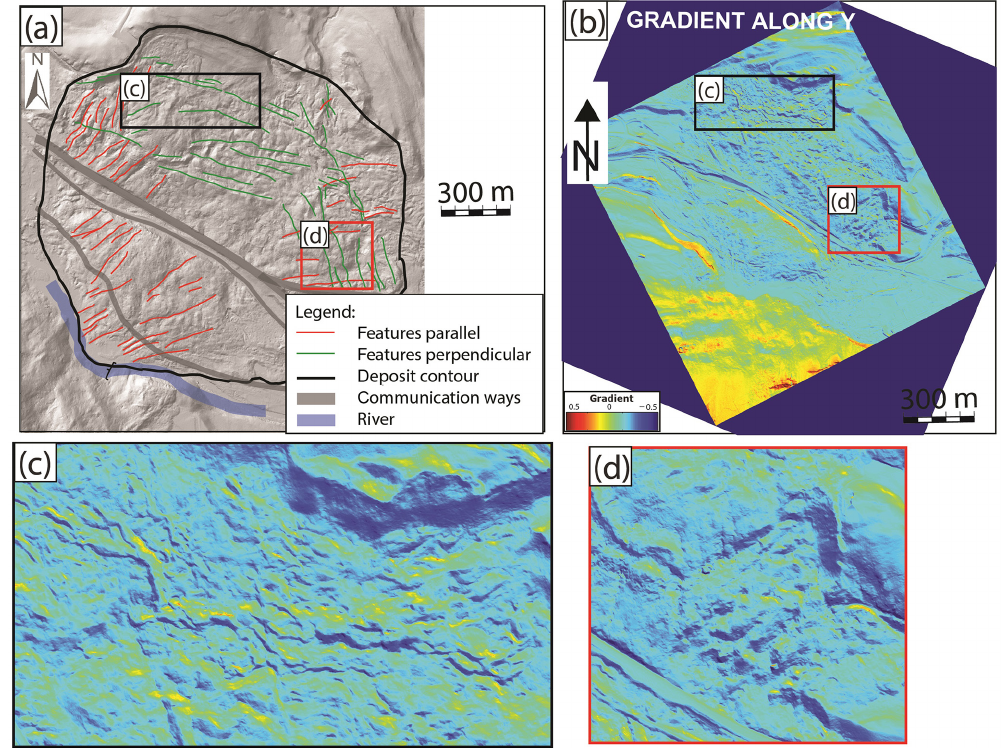
Figure 9. (a) Map of the different features observed in the DEM of the Frank Slide deposit; (b) result of the gradient along y applied to the DEM of Frank Slide; (c) zoom on features perpendicular to the flow direction; (d) zoom on features parallel to the flow